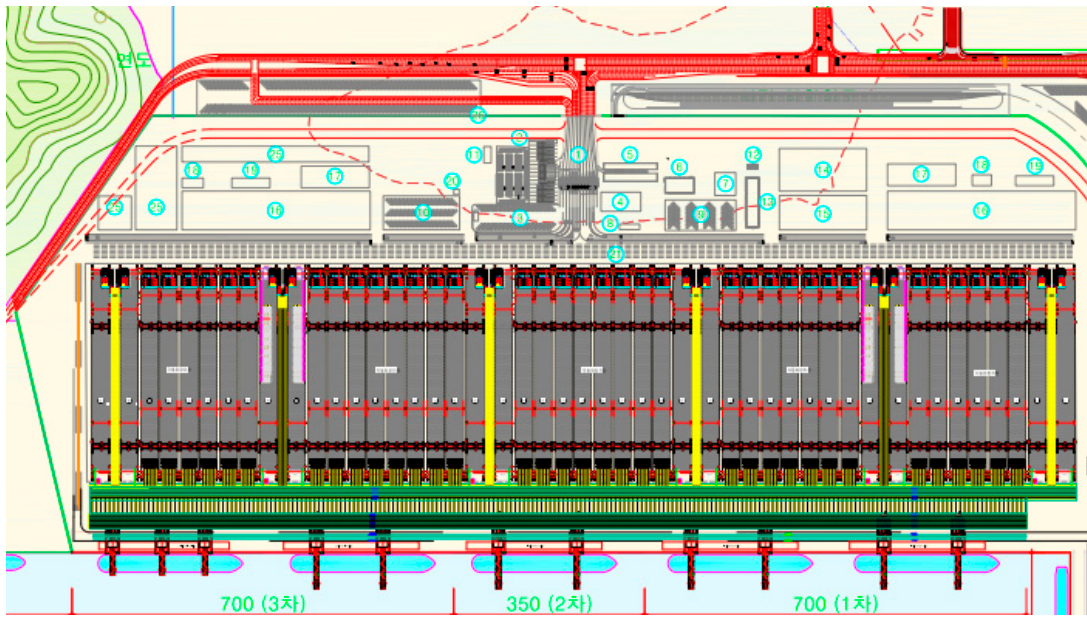
Figure 2. Layout of ACT in The New Port of Busan (Phase 2–5,2–6) (Source: Ministry of Ocean and Fisheries